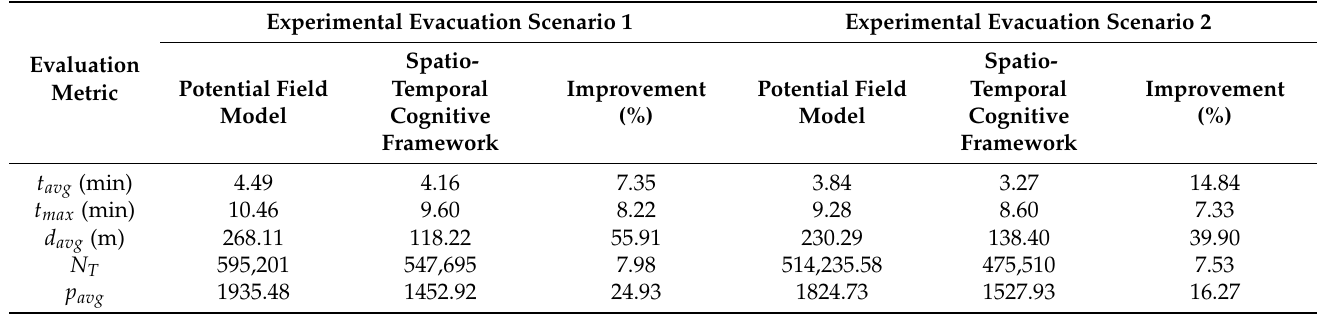
Table 3. The performance of crowd evacuation simulation with different crowd